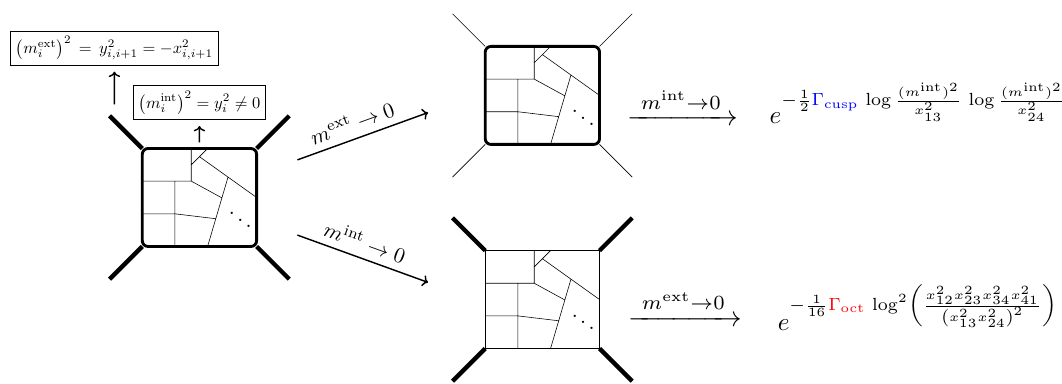
Figure 10 . Different massless limits of Coulomb branch amplitudes lead to very different exponential behavior. Both objects in the middle column are